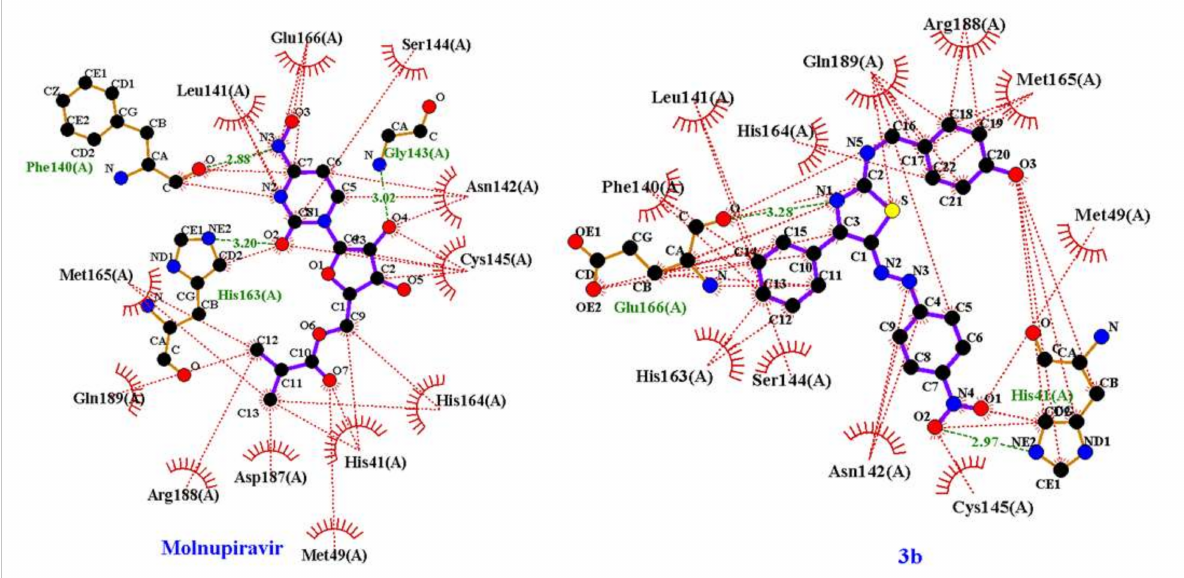
Figure 4. A schematic 2D LIGPLOT representation of Molnupiravir and 3b against the complex 7BQY showing the hydrogen and hydrophobic